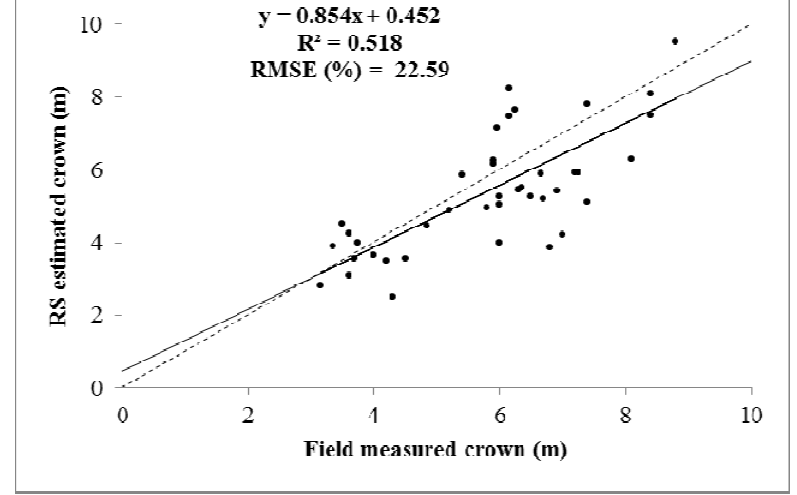
Figure 6. Correlation between field-measured and image-extracted crown widths for the Thessaloniki site. The solid line represents the line of best fit by linear regression analysis, and the hatched line depicts the line of